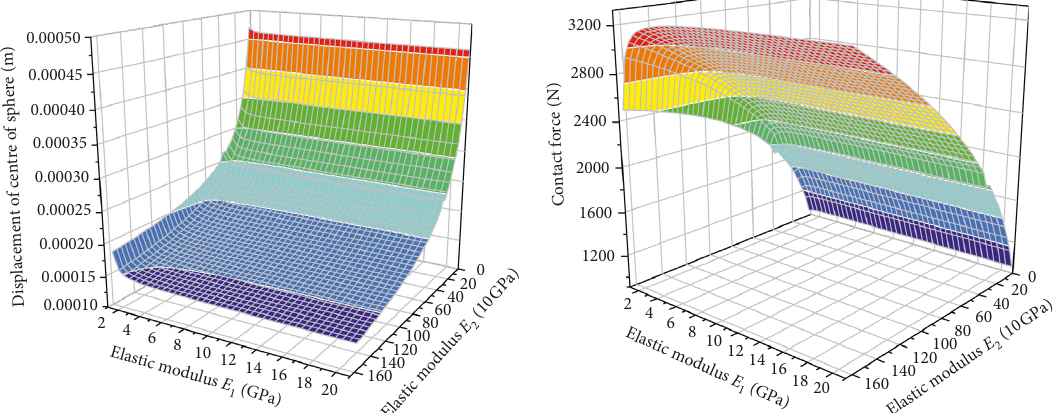
Figure 15: Effect of E E 1 and 2 on DCS and contact force in the contact process of elastic sphere which has similar properties with rock impacting the metal